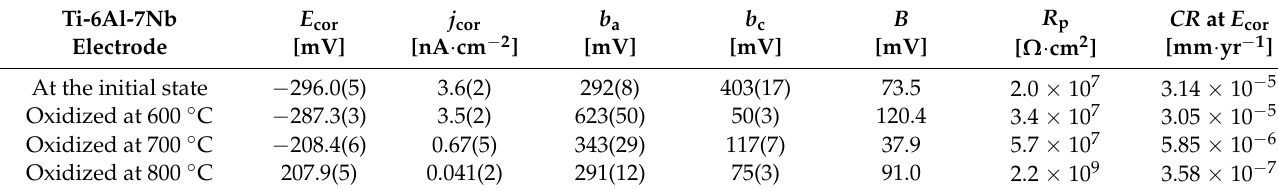
Table 4. The corrosion resistance parameters for the Ti-6Al-7Nb alloy before and after isothermal oxidation determined in a saline solution at 37 ◦ C based on analysis of the polarization curves shown in Figure 8 and according to ASTM G102—89(2015)e1